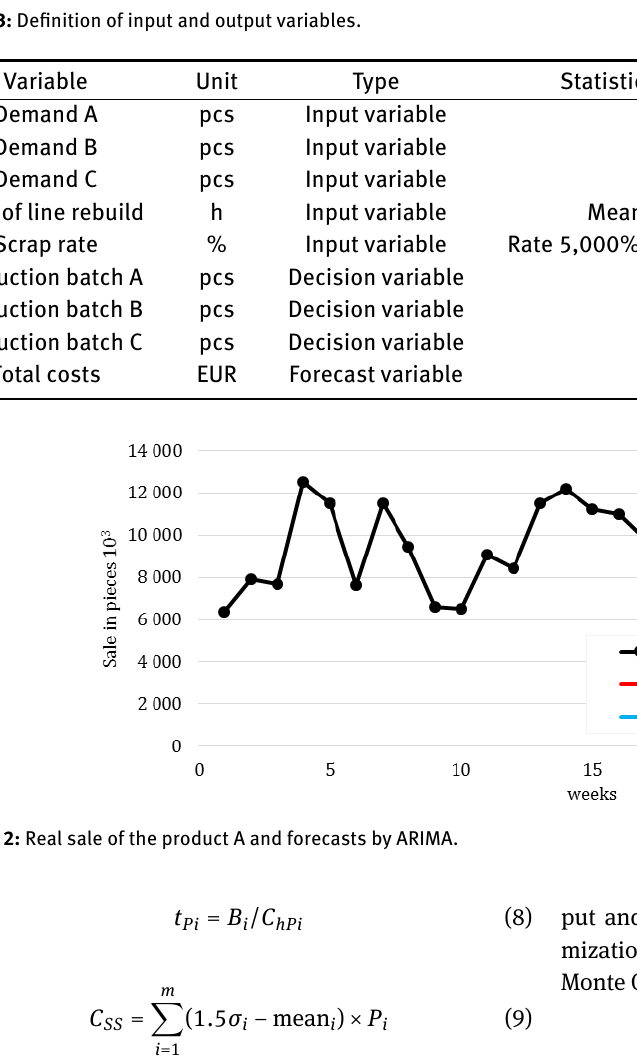
Table 3: Definition of input and output variables.